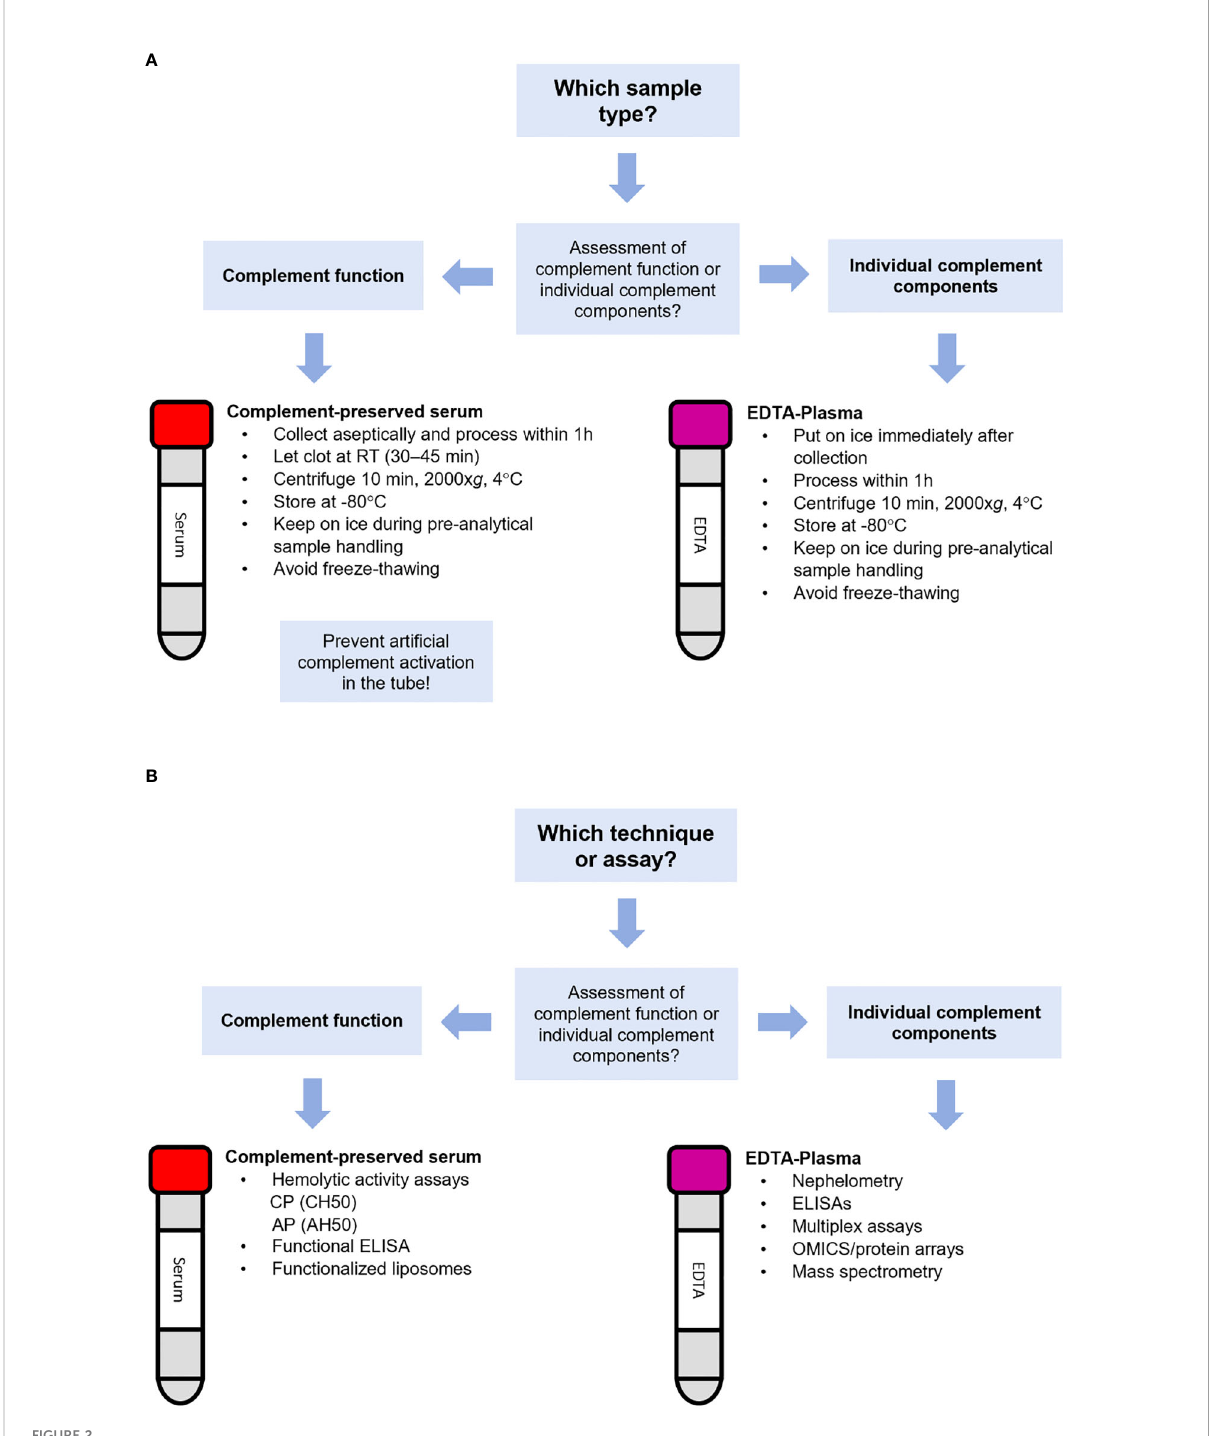
FIGURE 2 Flowchart for the selection of the appropriate sample type and technique for complement analysis. Flowchart for selection of (A) the appropriate sample type or (B) the appropriate technique for the assessment of